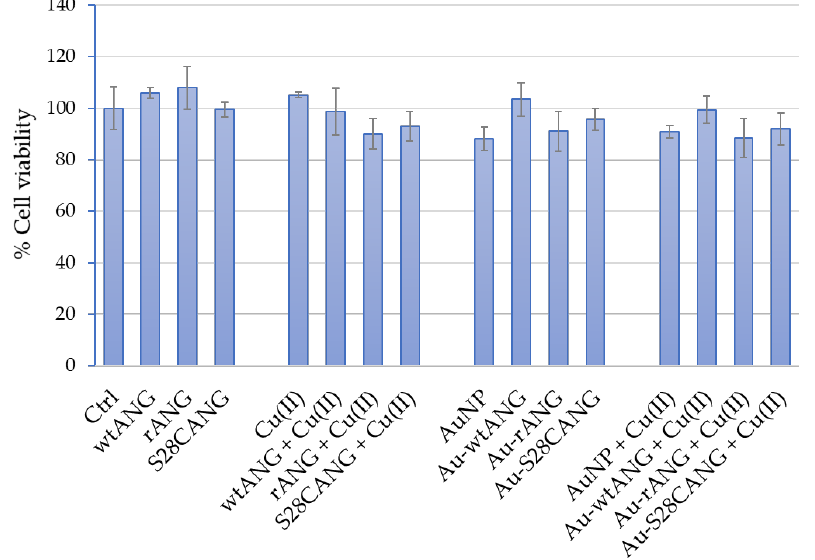
Figure 6. Cell viability assay (MTT) on HUVECs untreated (negative control) or treated for 24 h with: 20 nM free ANG proteins; 100 nM CuSO 4 ; ANG—copper complexes ([Cu(II)]/[ANG] = 5); bare AuNP and AuNP-ANG hybrids, in the absence or presence of 100 nM CuSO 4 . The following nanoparticle concentrations were used: 0.5 nM AuNP (8.45 × 10 6 NP /mL); 0.2 nM Au-wtANG (2.77 × 10 6 NP /mL); 0.3 nM Au-rANG (2.32 × 10 7 NP /mL); 0.2 nM Au-S28CANG (1.96 × 10 6 NP /mL). The bars represent means ± S.D. of three independent experiments performed in triplicate (S.D. = standard deviation).